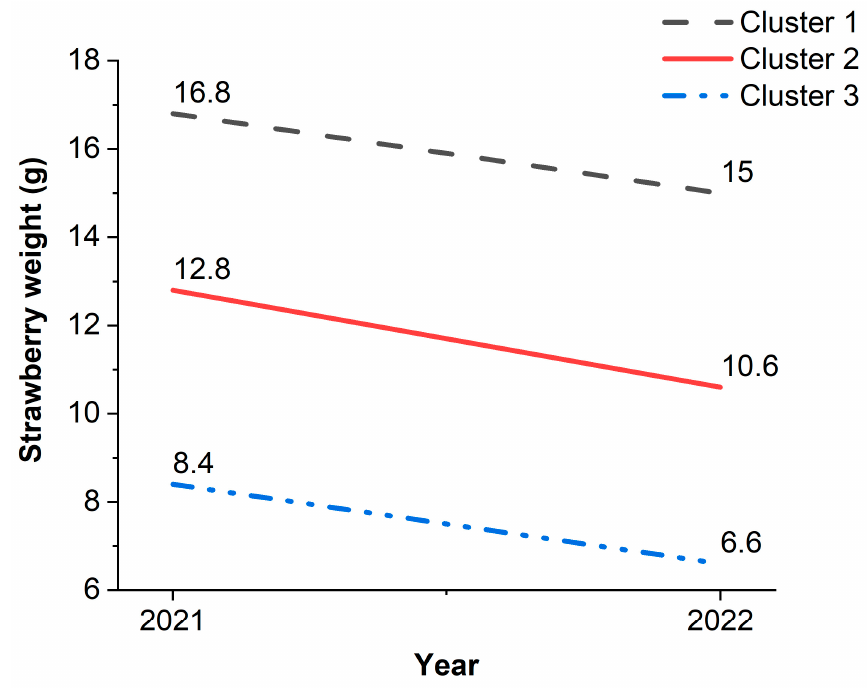
Figure 3. Grouping cultivars of strawberries by average berry weight by the K-mean cluster analy- sis.